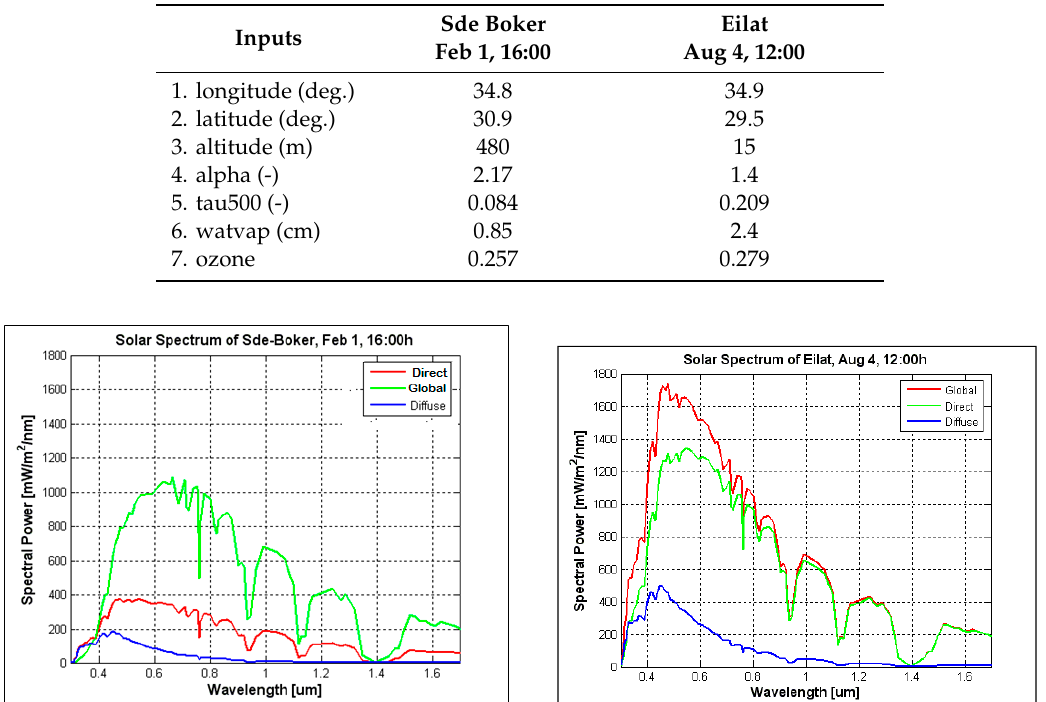
Figure 2. Spectrum at Sde Boker and Eilat-global, direct, di ff use.